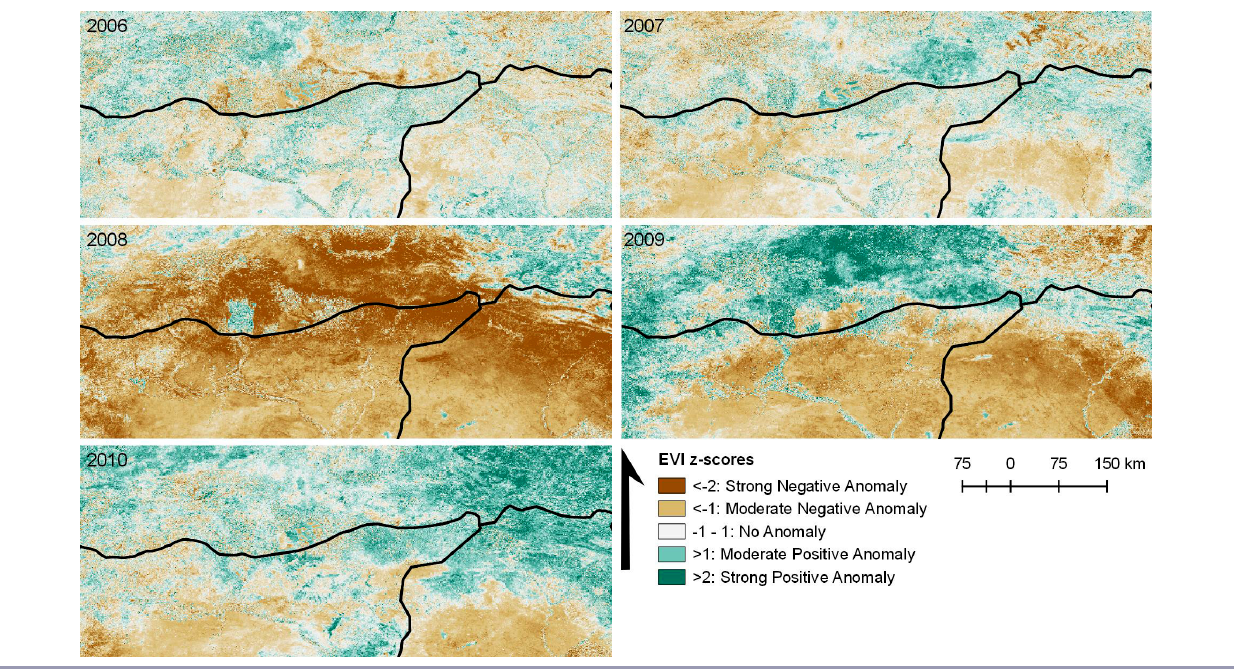
Fig. 5. Drought represented by vegetation anomalies 2006–2010 based on EVI for